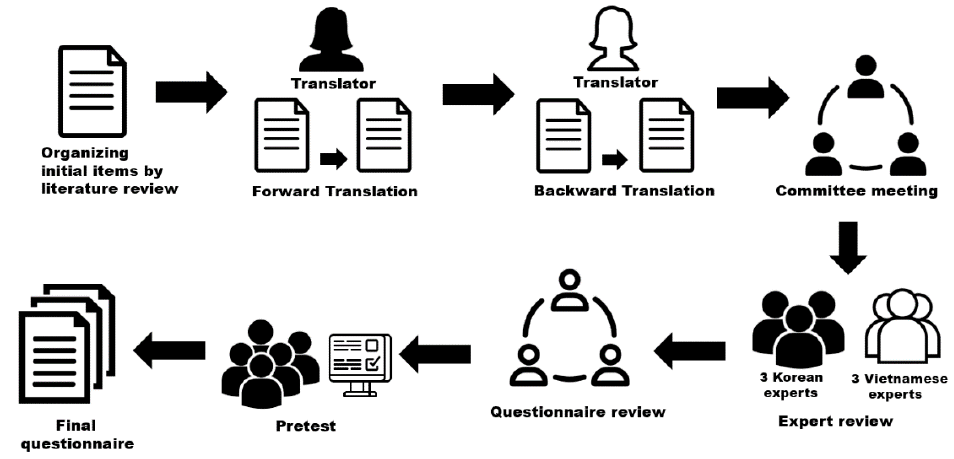
Figure 1. Questionnaire development and translation process.